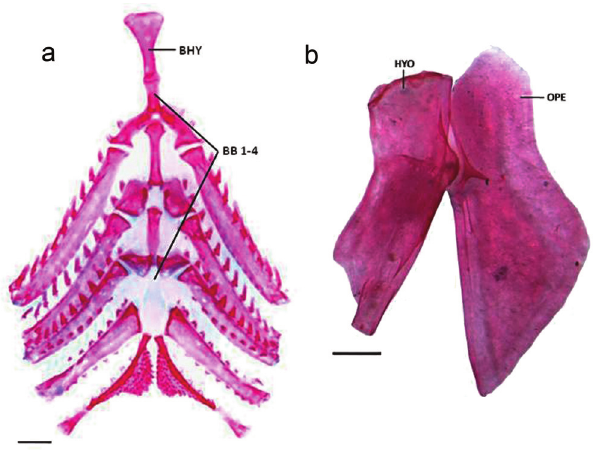
Fig. 9. Branchial skeleton, dorsal view (a) and posterior region of suspensorium (b) of Probolodus sazimai , MCP 13813, paratype, 43.5 mm SL. BHY: basihyal, BB 1-4: first to fourth basibranchials, HYO: hyomandibula, OPE: opercle. Scale bars = 1 mm.